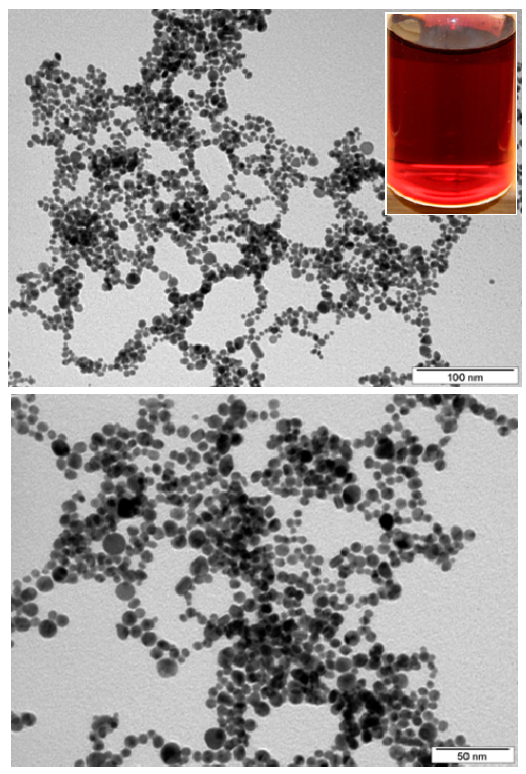
Figure 7. TEM images of Au nanoparticle solutions in PEG/H 2 O obtained by cathode sputtering, prepared at 30 mA and 300 s with ratio 1:9 .